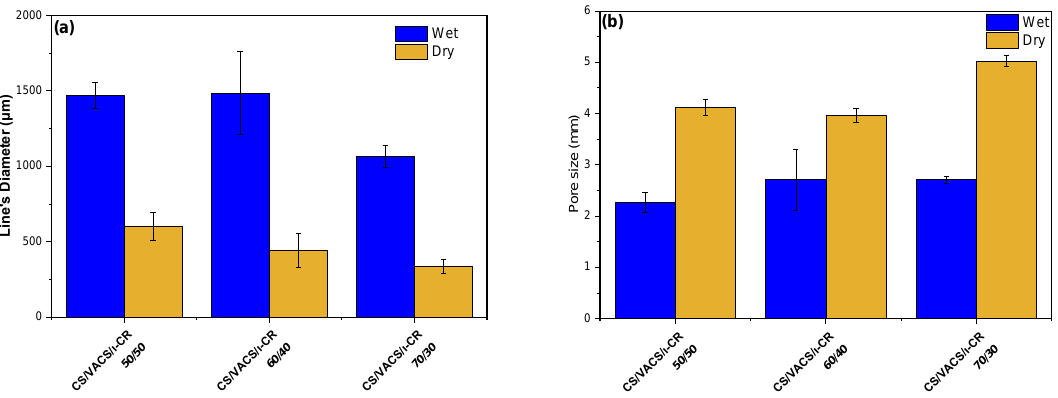
Figure 4. Average ( a ) scaffold’s line diameter and ( b ) pore sizes of the samples CS/VACS/iCR 50/50, 60/40, and 70/30. Five measurements were performed for each sample.